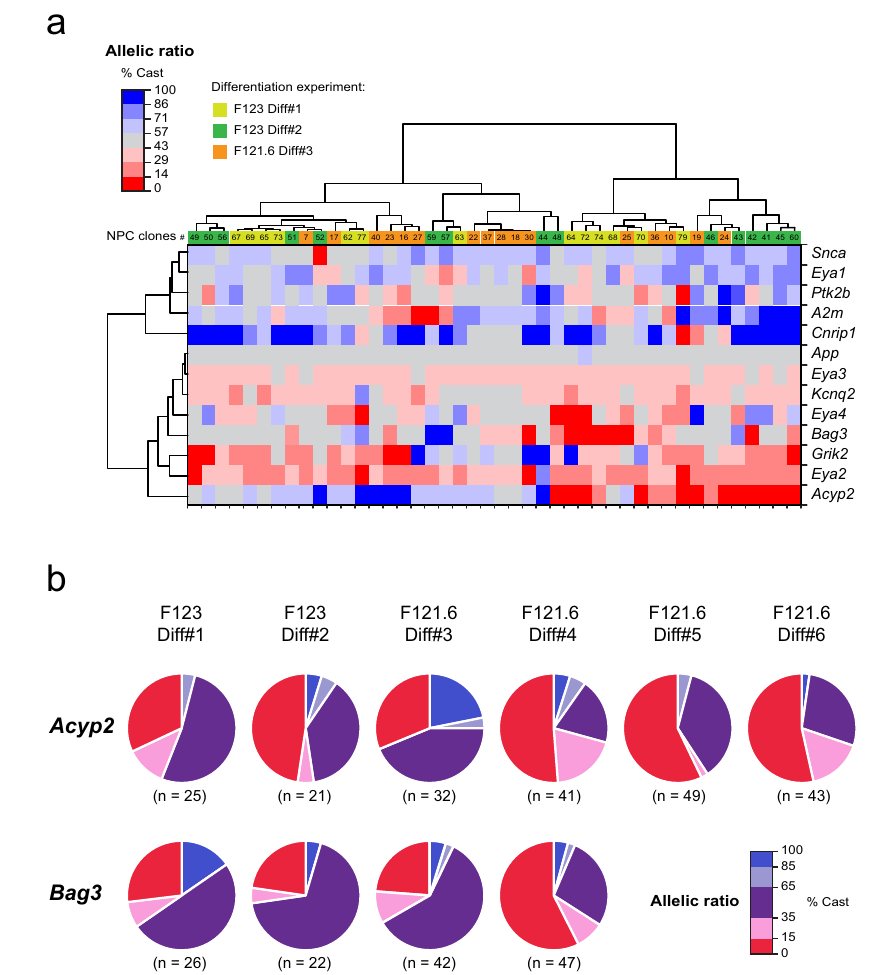
Fig. 4 Allelic imbalance generates cellular diversity. a Hierarchical clustering heatmap of allelic expression ratios for 13 genes in 44 NPC clones. b Proportions of NPC clones in each category of allelic expression status for Acyp2 and Bag3 for six independent differentiation experiments. n is the number of clones analysed for each gene and each